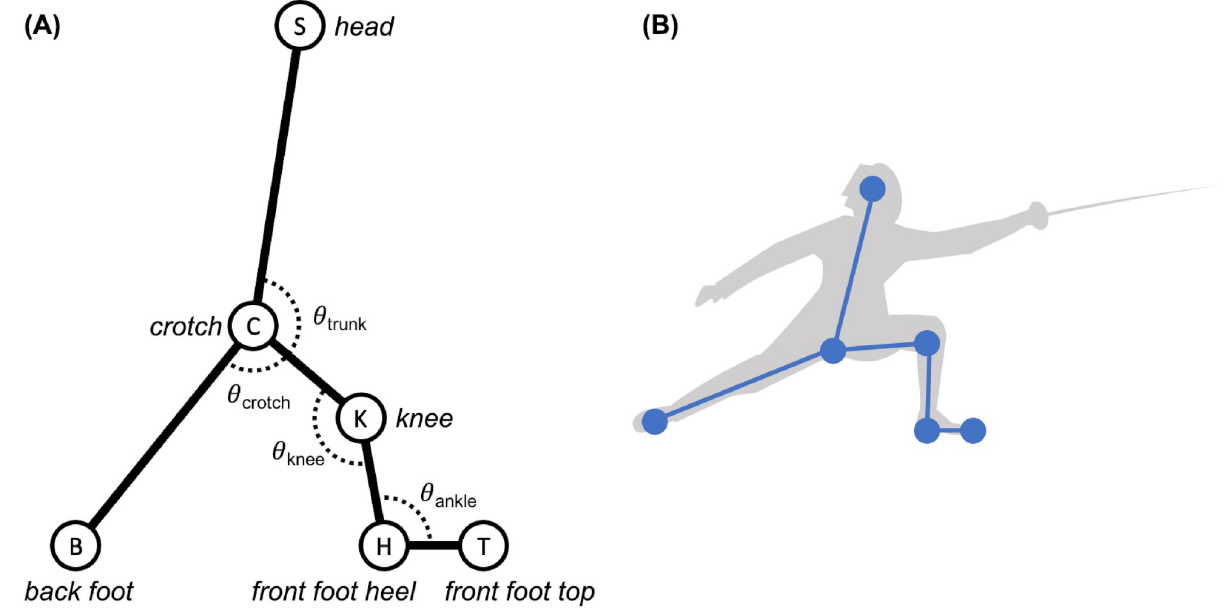
Fig 11. Kinematic model. (A) It is composed of segments and joints. CS = trunk, CB = rear lower limb, CK = front thigh, KH = front leg, HT = front foot, y ¼ d SCK , y ¼ d KCB , y ¼ d HKC , y ¼ d KHT . (B) Implementation of this model based on video tracking. trunk crotch knee ankle